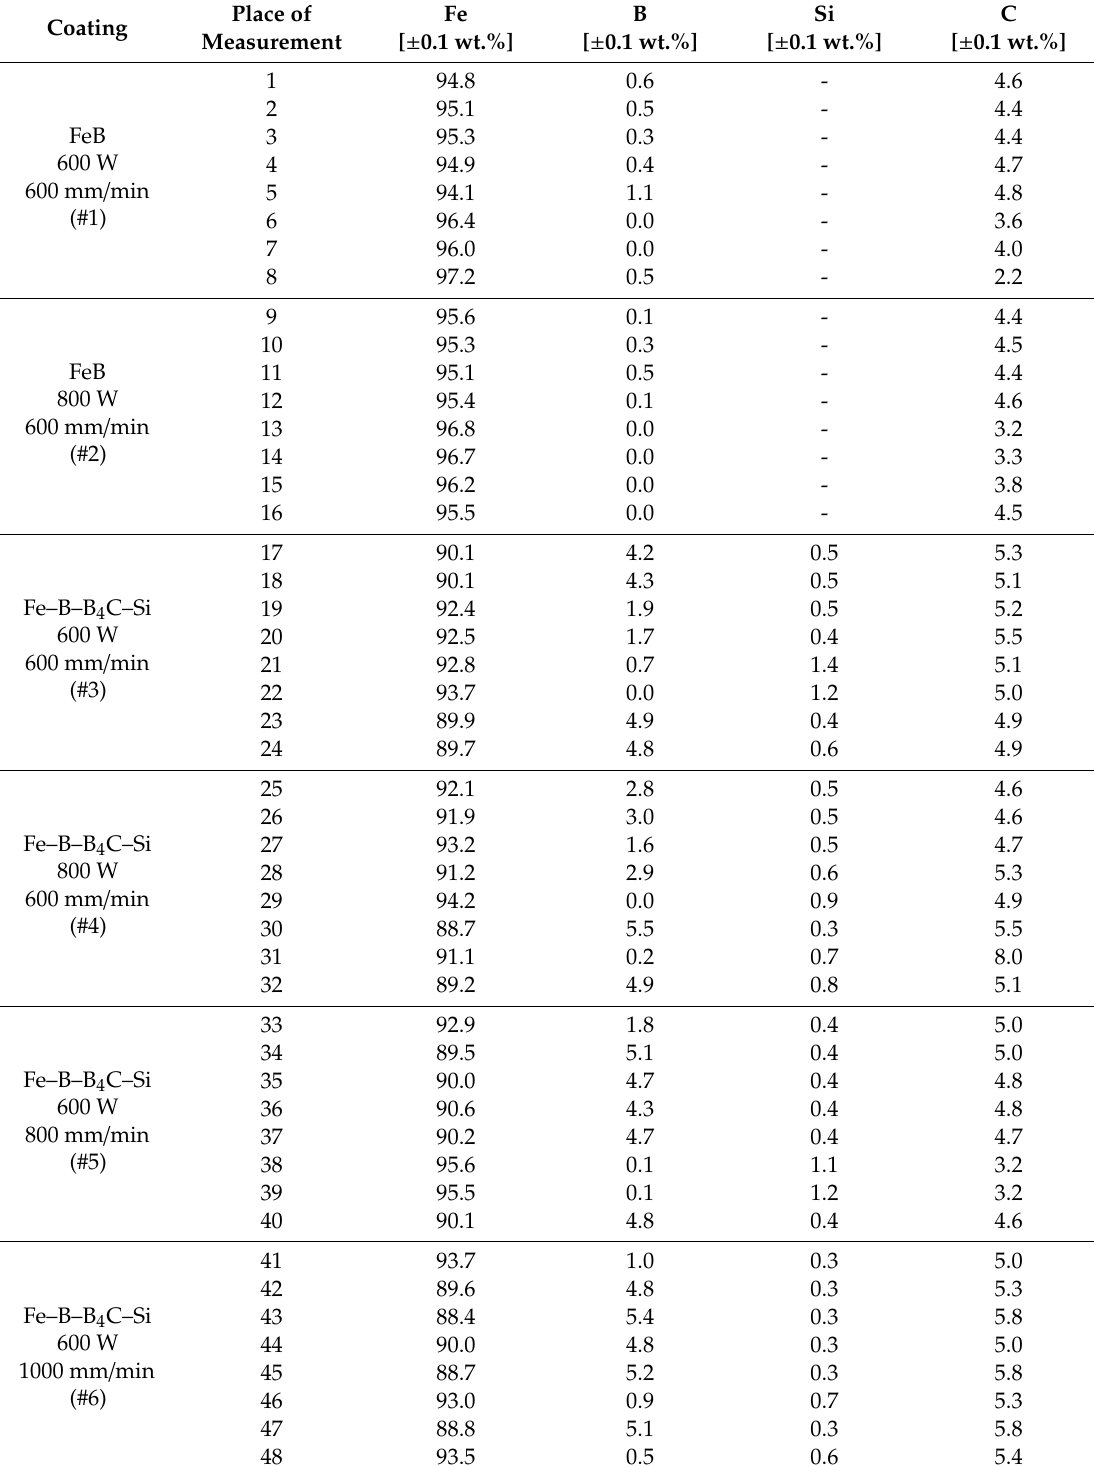
Table 3. Results of EDS point analysis of produced coatings marked in Figures 4 and